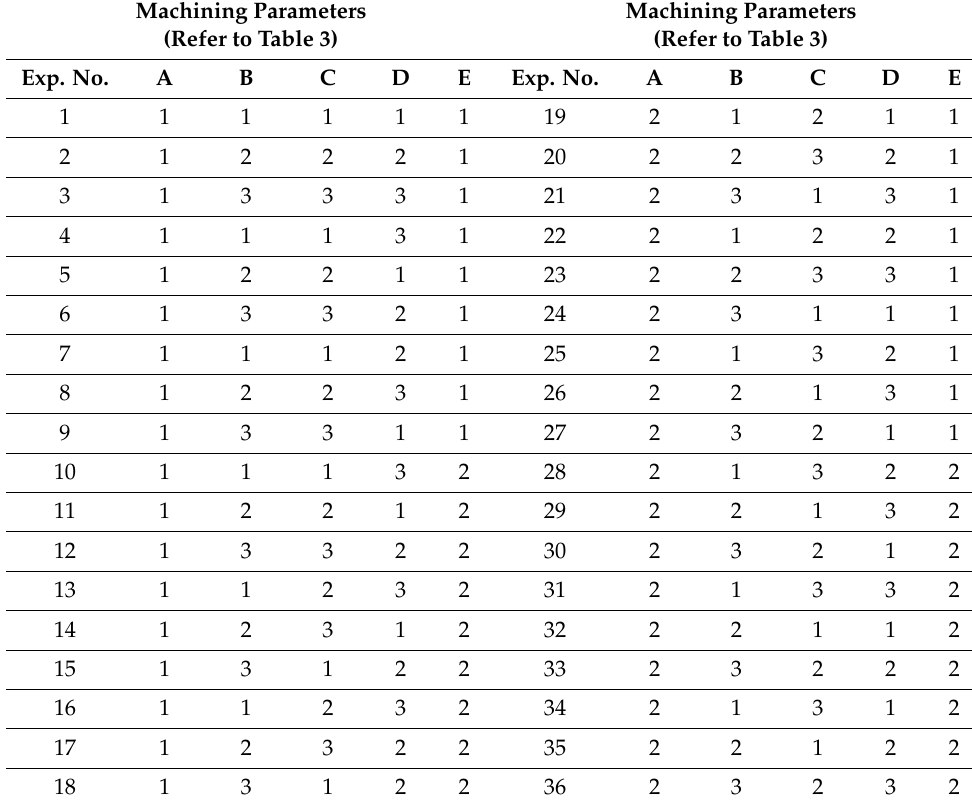
Table 4. Levels of machining parameters based on L36 standard orthogonal array.